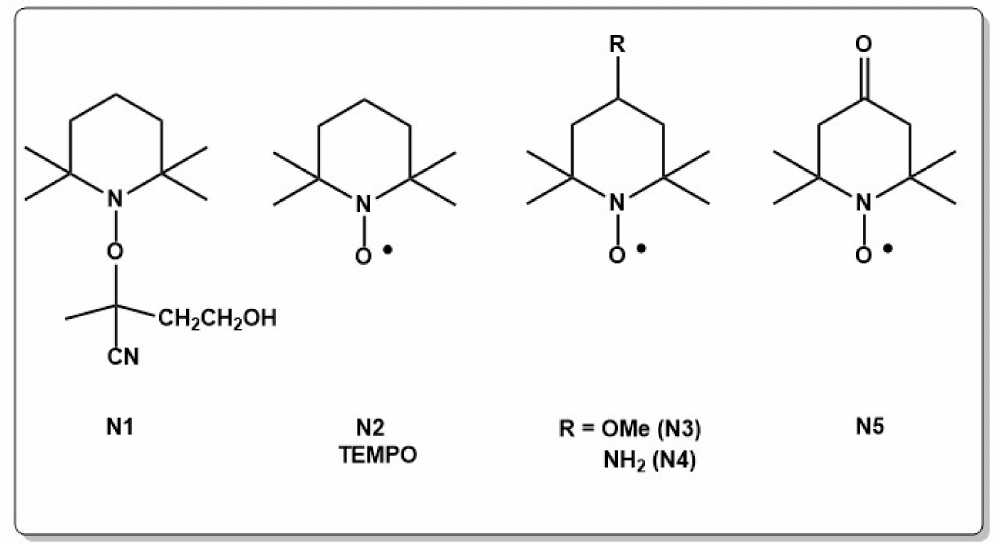
Chart 1. TEMPO derivatives used as nitroxides in